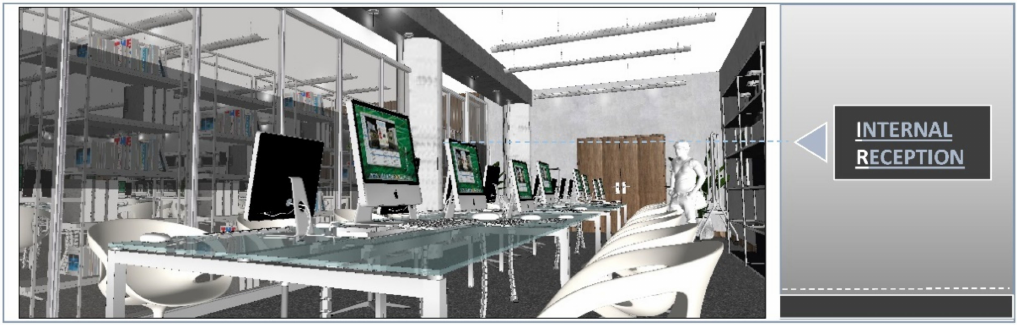
Figure 14. The internal perspective of an online search room consists of two glass